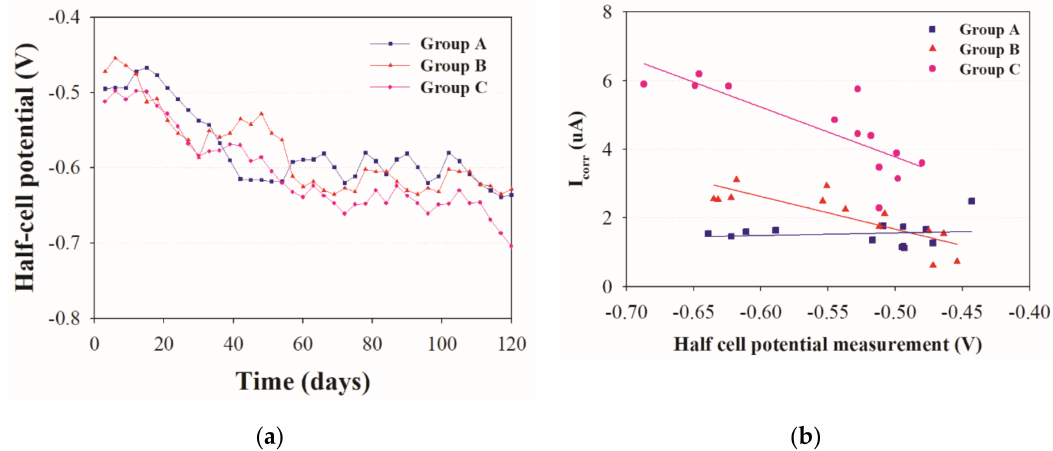
Figure 5. ( a ) Half-cell potential vs. time; ( b ) Corrosion current vs. half-cell